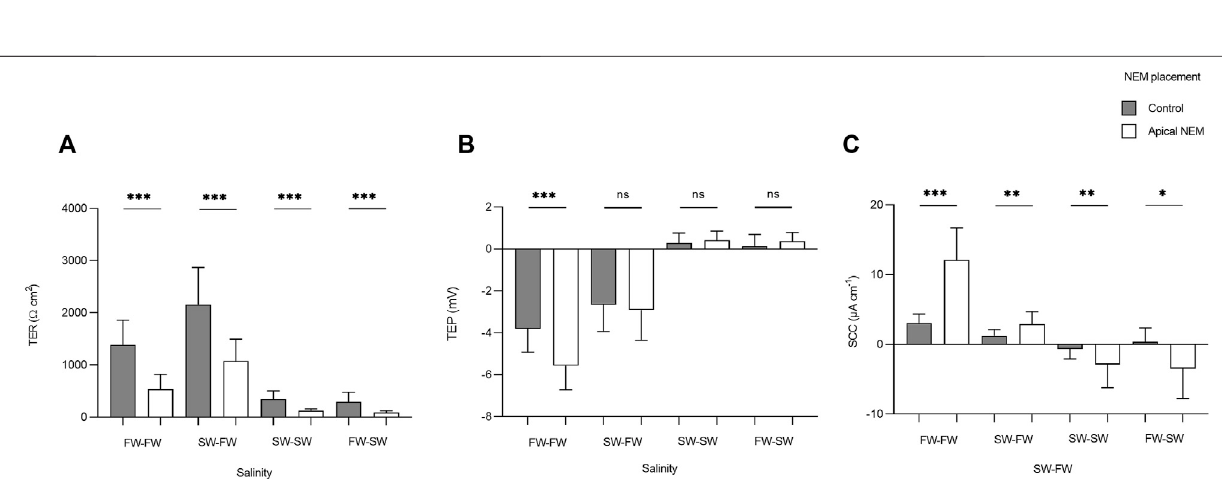
FIGURE 7 | Barcharts showing the effect of basal (control) and apical N-ethylmaleimide (NEM) addition on (A) transepithelial resistance (TER), (B) transepithelial potential (TEP), and (C) short-circuit current (SCC) for each salinity. Bars represent means and whiskers represent SD. Signi fi cant differences based on Welch tests are denoted with asterisks (*** p < 0.001; ** p < 0.01; * p < 0.05, ns, no signi fi cant